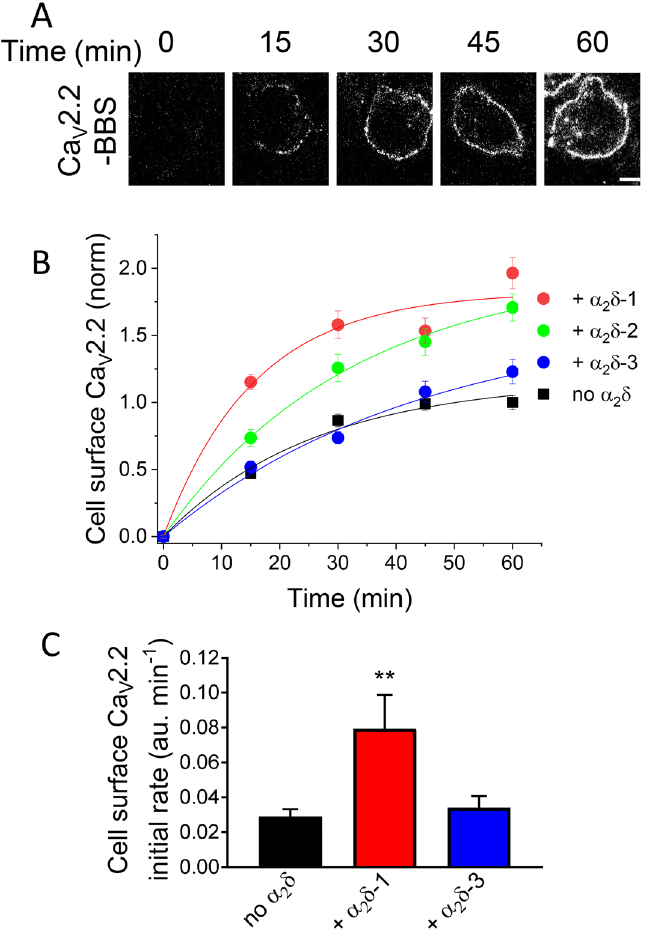
Figure 5. Net forward trafficking of Ca V 2.2-BBS is increased by α 2 δ-1 and α 2 δ-2, but not by α 2 δ-3. ( A ) Example images from forward trafficking assay for Ca V 2.2-BBS expressed in N2a cells with β1b and α 2 δ-1. Cells were live-labelled with α-BTX-AF488 for 0, 15, 30, 45, and 60 min, following pre-incubation with unlabelled α-BTX at 17 °C for 30 min. Scale bar = 5 μm. ( B ) Normalized mean cell-surface Ca V 2.2-BBS fluorescence in cells expressing Ca V 2.2-BBS and β1b alone (black) or with either α 2 δ-1 (red), α 2 δ-2 (green) or α 2 δ-3 (blue). An average of 30—60 cells were analysed per time point, for each condition in an individual experiment. The data were collected as paired experiments between Ca V 2.2/β1b (control) and Ca V 2.2/β1b + α 2 δ (n = 3 each), with a total of 9 for Ca V 2.2/β1b. Individual experiments were normalized to mean 60 min fluorescence of the paired Ca V 2.2/β1b condition, before being pooled together. Data were fitted with an exponential association equation; the time constant (τ) = 26.1 min (no α 2 δ), 15.6 min (+ α 2 δ-1), 32.4 min (+ α 2 δ-2) and 44.9 min (+ α 2 δ-3) and asymptotic normalized cell-surface Ca V 2.2 (amplitude) = 1.17 (no α 2 δ), 1.82 (+ α 2 δ-1), 2.0 (+ α 2 δ-2) and 1.63 (+ α 2 δ3). ( C ) Initial rate of net forward Ca V 2.2-BBS trafficking. The gradient of straight line between 0–15 min was obtained as an average for each individual experiment and summarised (in a.u. / min), for Ca V 2.2/β1b control (black, n = 9), Ca V 2.2/β1b + α 2 δ-1 (red, n = 3), and Ca V 2.2/β1b + α 2 δ-3 (blue, n = 3). Data are mean ± SEM. Statistical significance determined by one-way ANOVA (F = 9.333, P = 0.0036) and Dunnett’s multiple comparison test vs no α 2 δ, ** P =